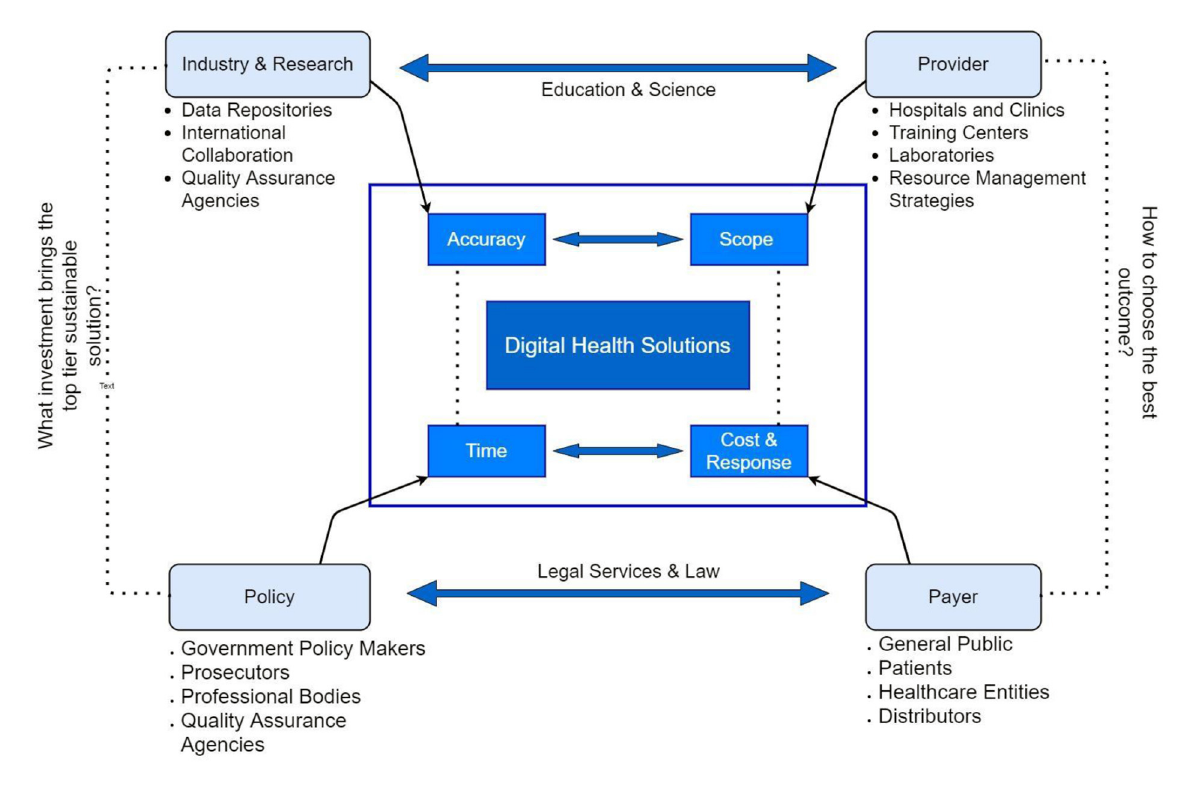
FIGURE1 Governing factors on personalized health